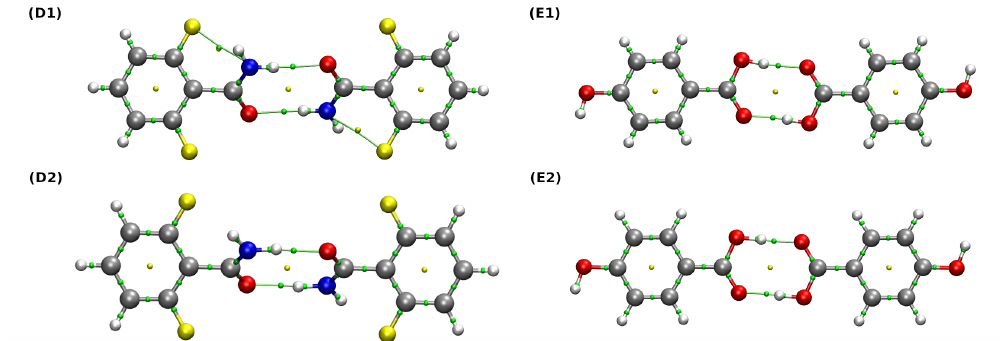
Figure 7. QTAIM molecular graphs of the studied dimers. Ball and stick model was used for visualization. Bond paths, BCPs and RCPs are presented as green lines and small green and yellow spheres, respectively. Color coding: white—hydrogen, grey—carbon, red—oxygen, blue—nitrogen, yellow—fluorine. ( D1 , E1 ) are the experimental structures, whereas ( D2 , E2 ) are the structures after the relaxation at the ω B97XD/def2-TZVP level of theory.